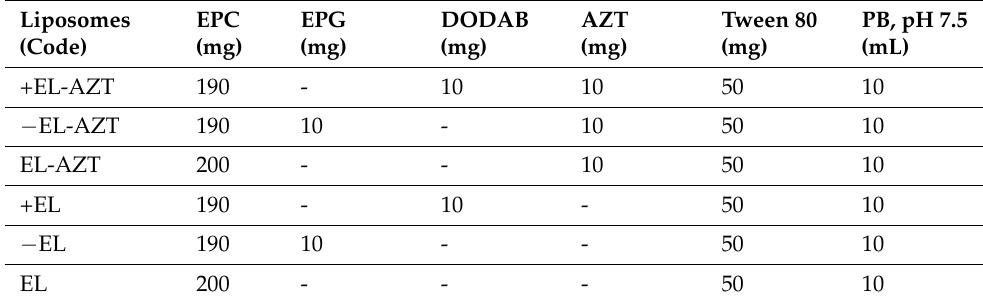
Table 1. Composition of